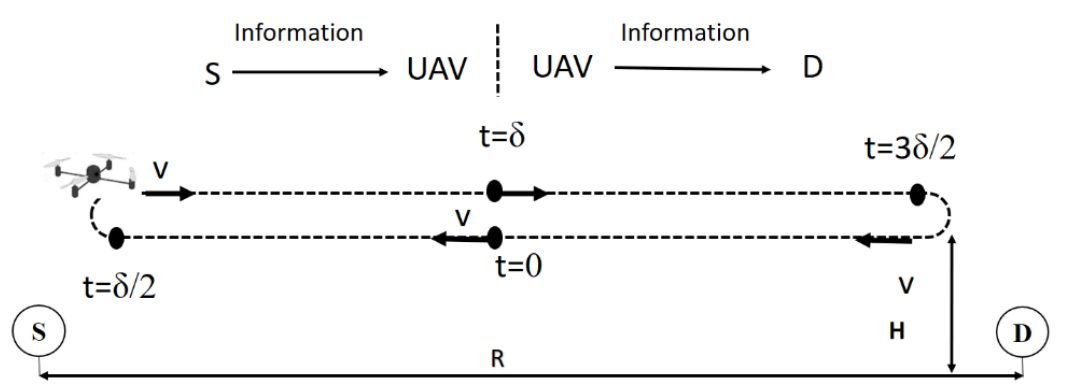
Figure 6. A scenario where the UAV is used as